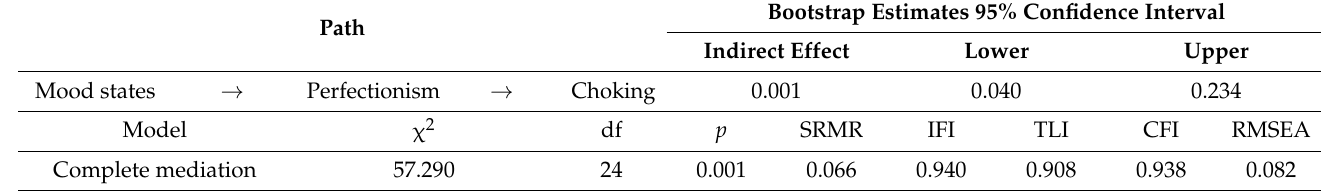
Table 6. Mediating effect analysis through